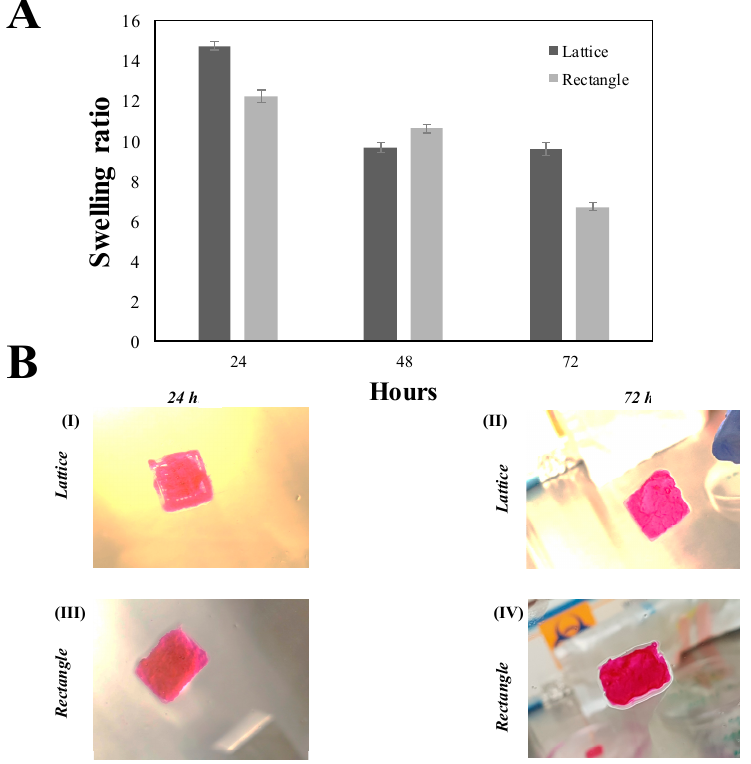
Figure 4. ( A ) Swelling analysis for both the f-gelatin-based lattice and rectangular-sheets over a period of three days after being subjected to visible light crosslinking. ( B ) Shown above in ( BI , II ) is cell-laden lattice constructs. In ( BIII,IV ) is cell-laden rectangular-sheet constructs. ( BI , III ) was acquired after 24 h of culture. ( BII , IV ) was acquired after 72 h of culture. No significant differences in the degradation rates of both structures were evident at 72 h of incubation.